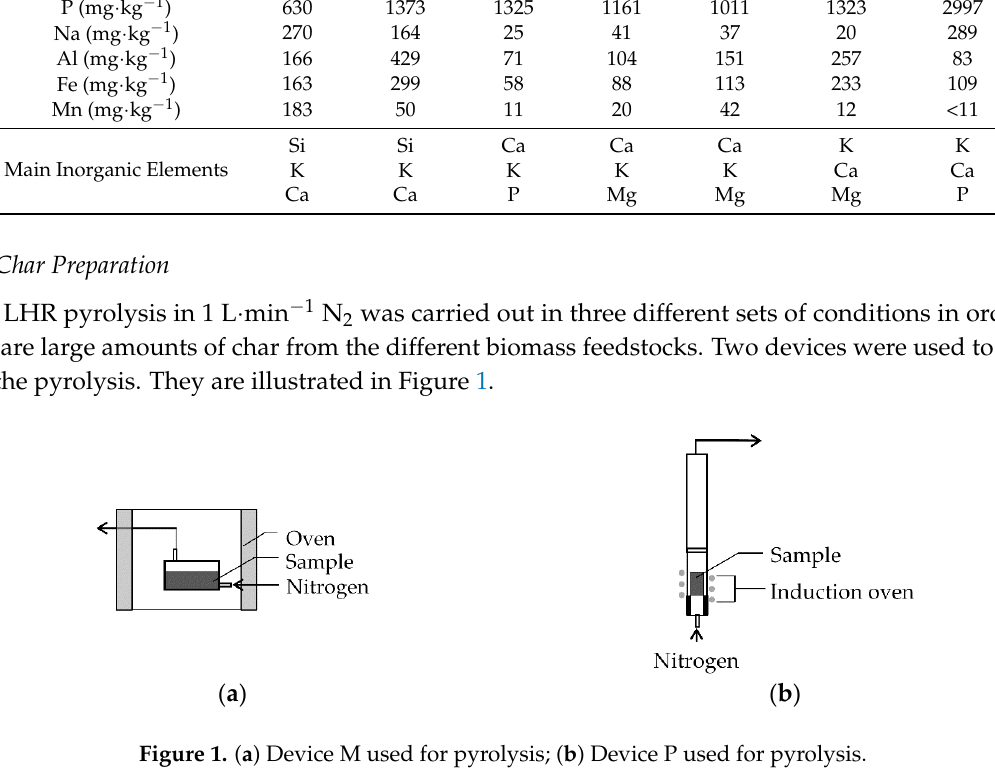
Table 2. Pyrolysis conditions for char preparation from the biomass samples.